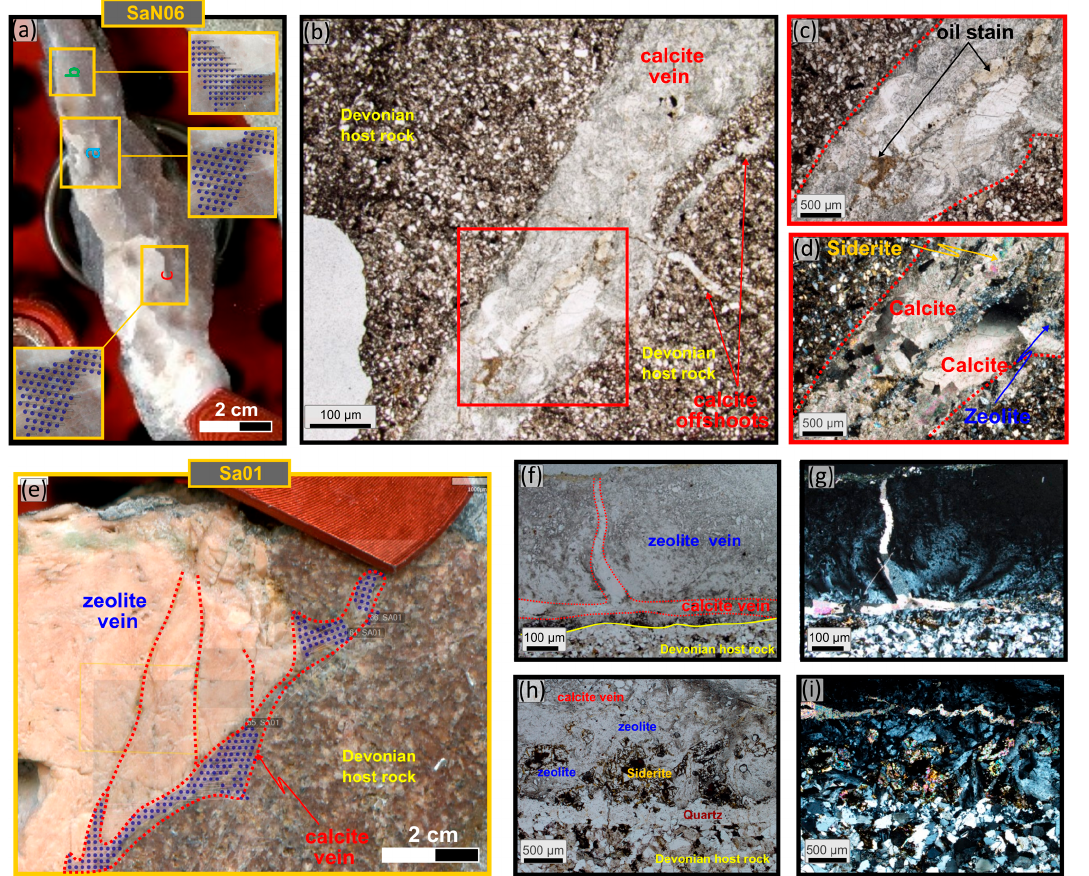
Figure 11. ( a ) Polished thick section of SaN06 sample showing the laser ablation spots (blue dots). ( b ) Microphotograph and detail of the calcite vein showing ( c ) oil stains and ( d ) occurrence of associated intergrown siderite and zeolite. ( e ) Polished thick section of mainly zeolite (pink) and calcite (grey) Sa01 sample also showing the laser ablation spots (blue dots). ( f – i ) Representative thin section microphotographs of Sa01 sample showing ( f ) in plane polarised light and ( g ) crossed polarised light the vein formed almost entirely of zeolite with thin calcite vein present at the boundary with Devonian host rock and as offshoots in the main zeolite vein. ( h ) in plane polarised light and ( i ) crossed polarised light, rare occurrence of early formed siderite and quartz along vein margins.